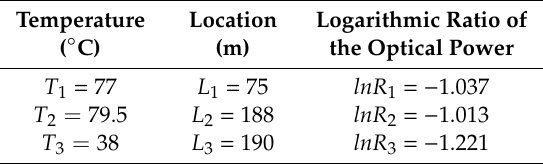
Table 1. The calibration experiment data.